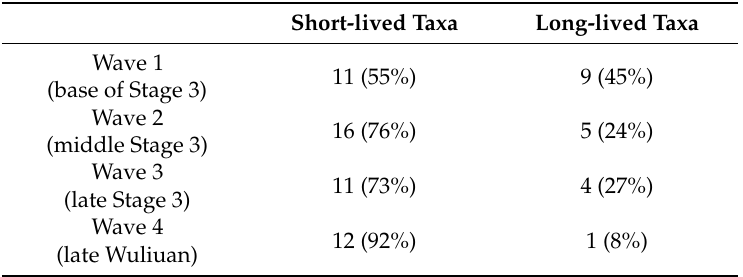
Table 1. Bradoriid Radiations. Data from